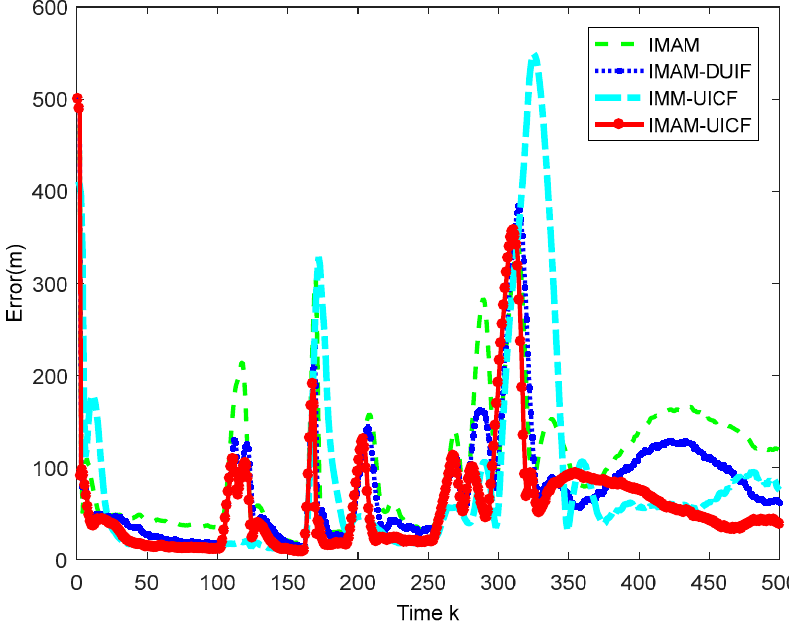
Figure 8. Position RMSE of different sensors.